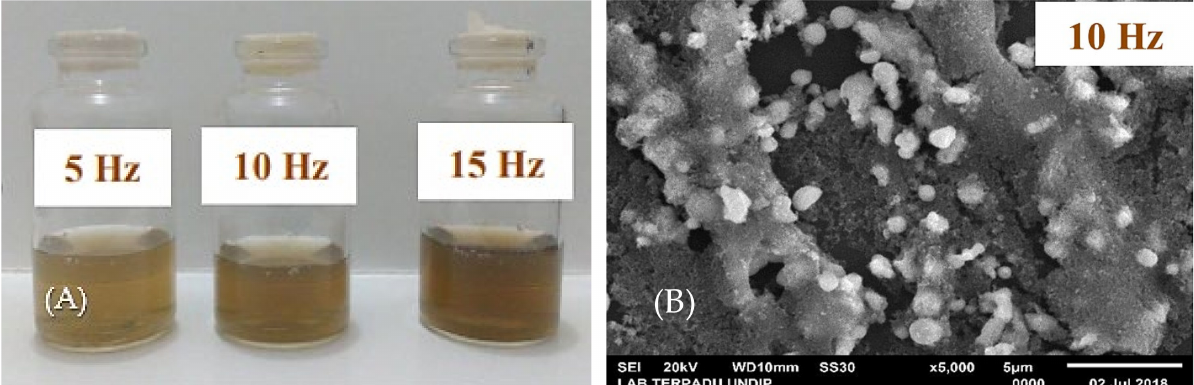
Figure 10. ( A ) Zn nanoparticles prepared using pulsed laser ablation of Zn in deionised water at different pulse frequencies of 5 Hz (light brown), 10 Hz (medium brown), and 15 Hz (dark brown). ( B ) Scanning electron microscopy images showing the morphology of dried Zn nanoparticles at a pulse repetition rate of 10 Hz. Adapted with permission from Ref. [124]. Copyright 2019,